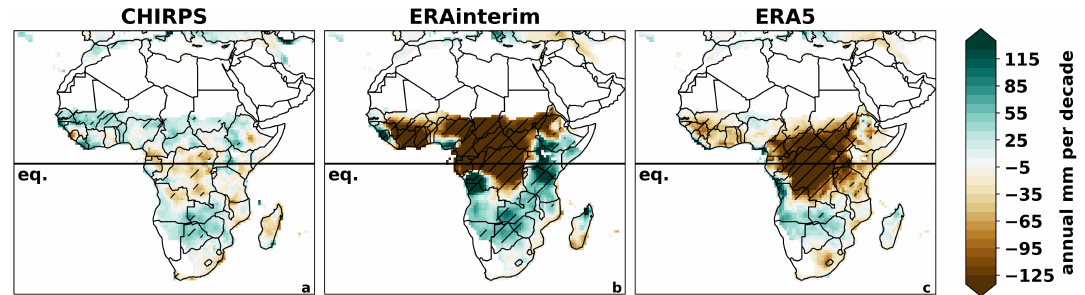
Figure 8. Trend of annually aggregated precipitation in observations (CHIRPS, ( a )), ERA-interim ( b ) and ERA5 ( c ) from 1981 to 2017. Hatching represents regions where trends are significant at the 1%